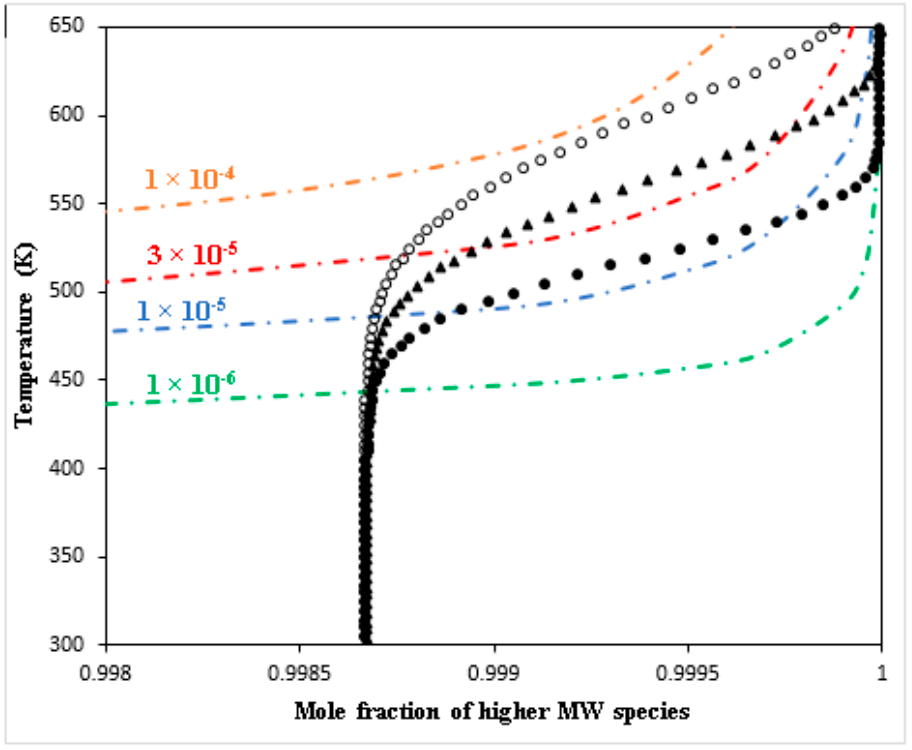
Figure 10. Effect of carrier gas flow rate on anthracene evaporation path during heat treatment of a 50 g pitch sample (assumed as one-phase glassy isotropic liquid); Solid circle: 2300 cm 3 /min, solid triangle: 560 cm 3 /min; empty circle: 230 cm 3 /min (heating rate: 50 ◦ C/h and φ i s : 1 ).